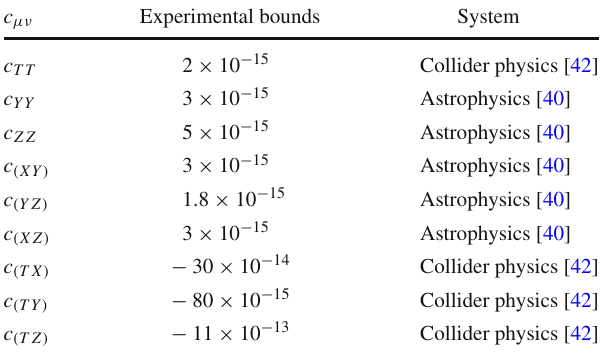
Table 1 Experimental bounds on components of